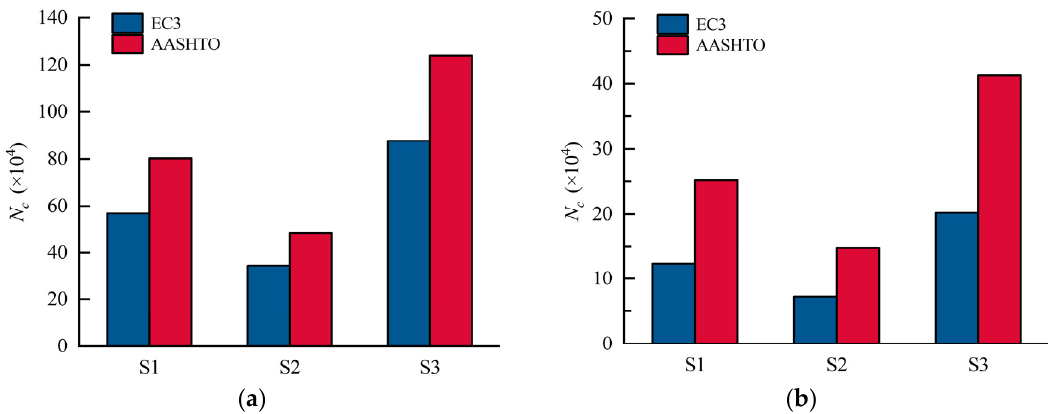
Figure 23. Fatigue lives of S1, S4, and S5 in different codes: ( a ) detail 2; ( b ) detail 4.